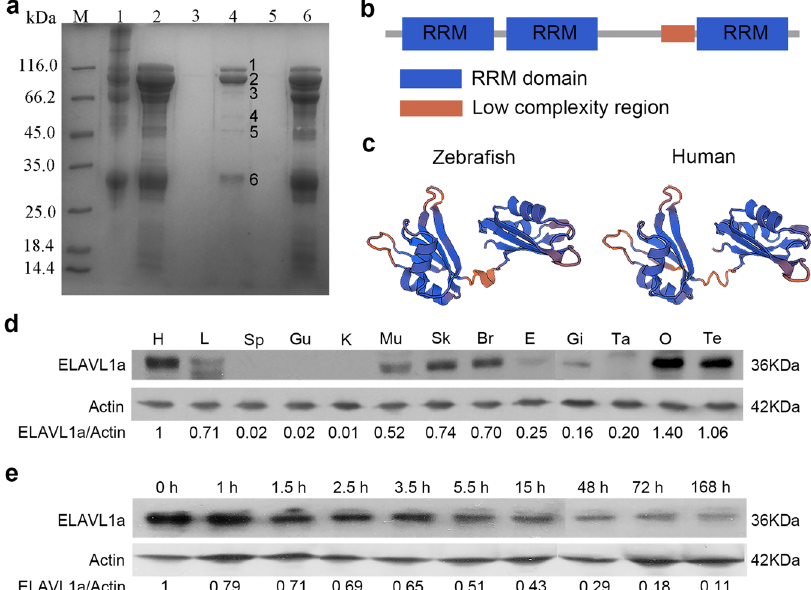
Fig. 1 Identi fi cation of ELAVL1a as an LTA-binding protein. a SDS-PAGE of the proteins isolated from the embryos extracts of zebra fi sh on LTA-conjugated Sepharose CL-4B af fi nity resin. Lane M, marker; lane 1, embryos extracts; lane 2, ef fl uent fractions after Tris-HCl wash; lane 3, ef fl uent fractions after throughout elution; lane 4, ef fl uent fractions containing the absorbed proteins; lane 5, ef fl uent fractions from LTA-conjugated Sepharose CL-4B af fi nity resin with no embryos extracts loaded; lane 6, ef fl uent fractions from Sepharose CL-4B af fi nity resin with no conjugated LTA. b Domain structure of ELAVL1a predicted by the SMART program. c 3D structures of the ELAVL1a generated by SWISS-MODEL online software using human ELAVL1 (PDB code: 4egl.1.A) as the model. d Western blotting of ELAVL1a in different tissues including heart (H), liver (L), spleen (Sp), gut (Gu), kidney (K), muscle (Mu), skin (Sk), brain (Br), eye (E), gill (Gi), ovary (O), testis (Te) and tail (Ta). e Western blotting of ELAVL1a at the different developmental stages including zygote (0h), 4-cell stage (about 1 h), 16-cell stage (~1.5h), 256-cell stage (~2.5h), high blastula stage (~3.5 h), 50% epiboly stage (~5.5h), 10-somite stage (~15 h), 2-day post- fertilization (2-dpf), 3-dpf, and 7-dpf. The values of the quanti fi cation of Western blotting were given as well. Data are presented as the means±